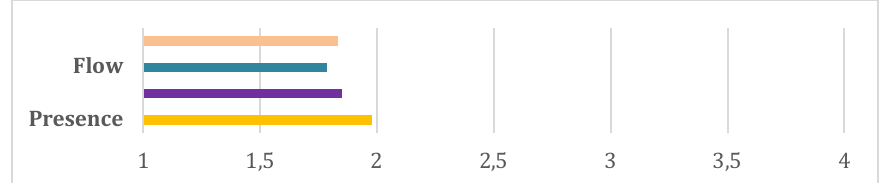
Fig. 6. Game engagement in academic secondary school